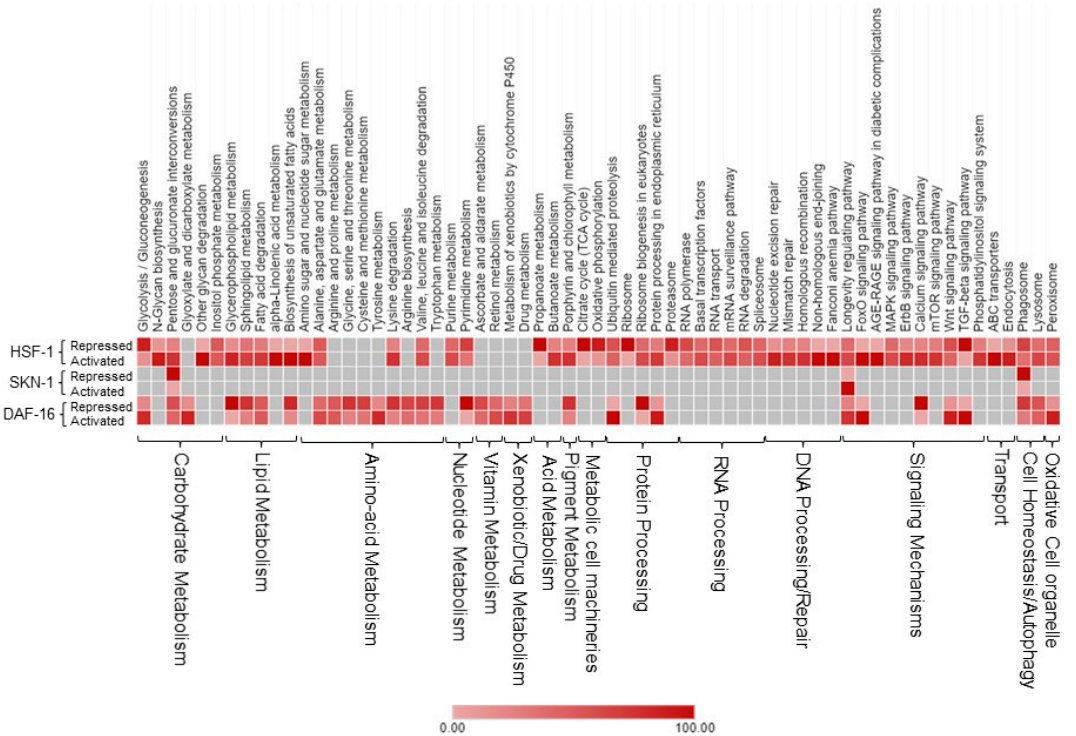
Figure A7. The relative percentage of differentially expressed genes regulated by the individual transcription factors are shown for each of the biological processes which were identified by gene network analysis.